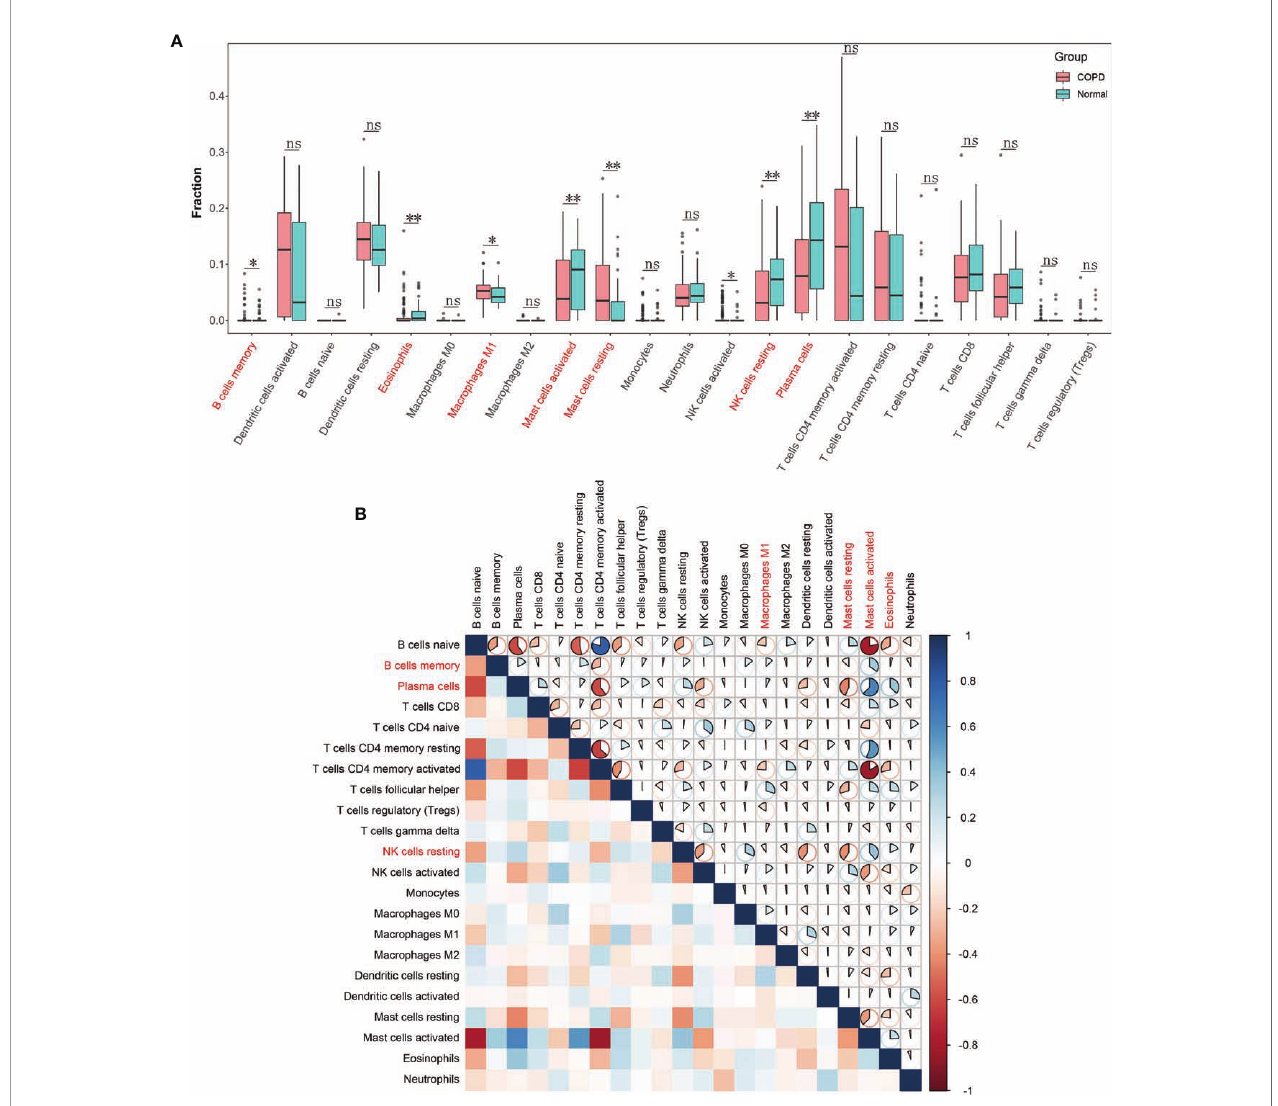
FIGURE 6 | Landscape of immune cell in fi ltration in chronic obstructive pulmonary disease. (A) Boxplot of the proportion of 22 types of immune cell in fi ltrates. Red in the boxes represents the chronic obstructive pulmonary disease group and blue represents the normal group. *P < 0.05; **P < 0.01; ns, not signi fi cant. (B) Heatmap plot of correlations among 22 types of immune cells. Blue and red indicate positive and negative correlation, respectively. The darker the color the stronger the